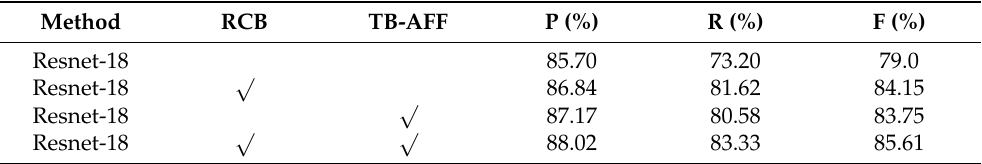
Table 4. Test results in MSRA-TD 500